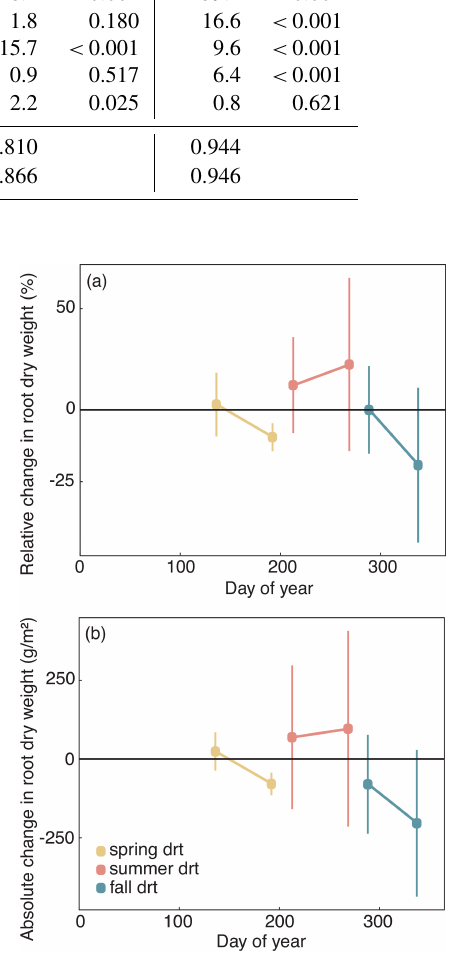
Figure 5. (a) Relative (RCG) and (b) absolute (ACG) changes in temperature-weighted growth rates (DMYT sum ) for the second growth period (weeks 6 to 10) of the respective drought (drt) treat- ment for 2014 and 2015 for the individual grasses. Values shown are means of four replicates per species and cultivar ( n = 4; ± SE). Dashed black lines represent the means across all grasses. See Fig. 4 for additional explanations. The corresponding statistical analyses are shown in Table A1 in the Appendix.